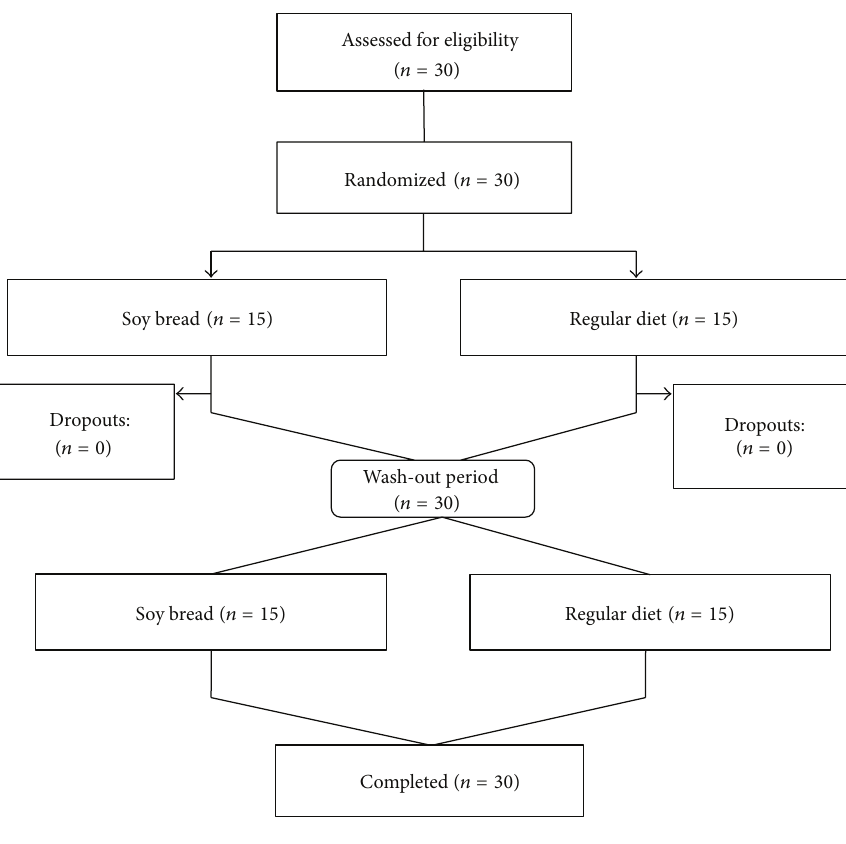
Figure 1: Participants flow